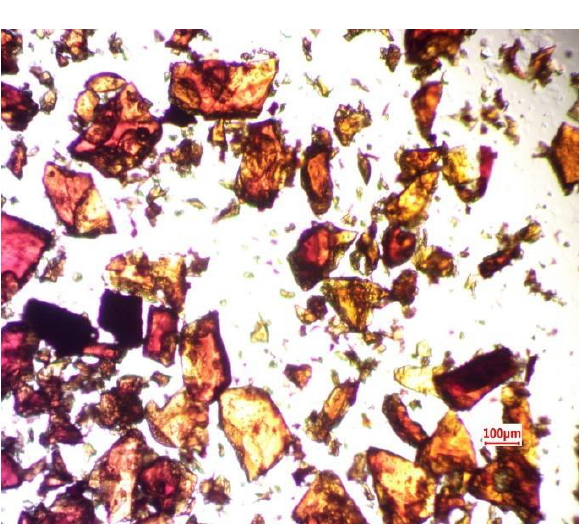
Fig. 2. Microphoto of a model sample of dry extract No.